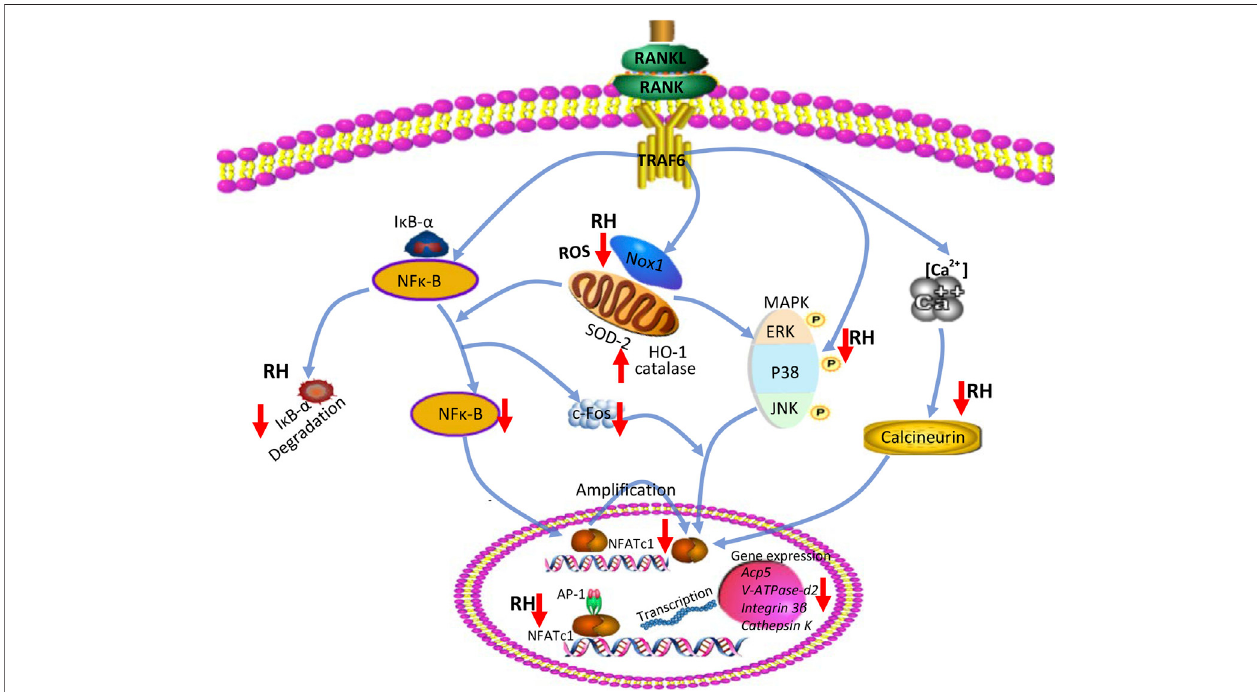
FIGURE 7 | A proposed diagram depicts the RH treatment on the inhibition of osteoclast formation and function. RH suppresses NF- κ B activity, ERK, and P38 phosphorylation and Ca 2+ oscillation, eventually leading to the deactivation of NFATc1 and its downstream osteoclast-speci fi c genes. In addition, RH treatment also reduced ROS level by inhibiting ROS production and boosting ROS scavenging